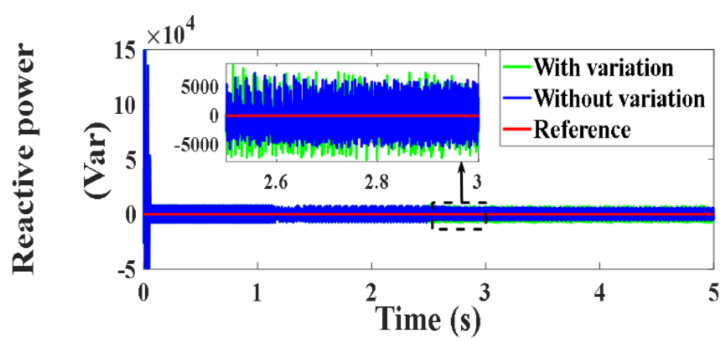
Figure 97. Active power under PVC (Watt).